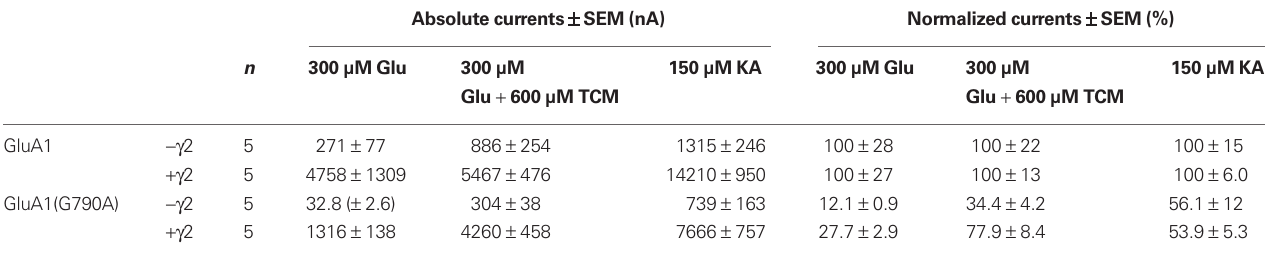
Table 3 | Absolute and normalized mean currents of gluA1 wild type and gluA1(g790A), in the absence and presence of the TARP γ 2.